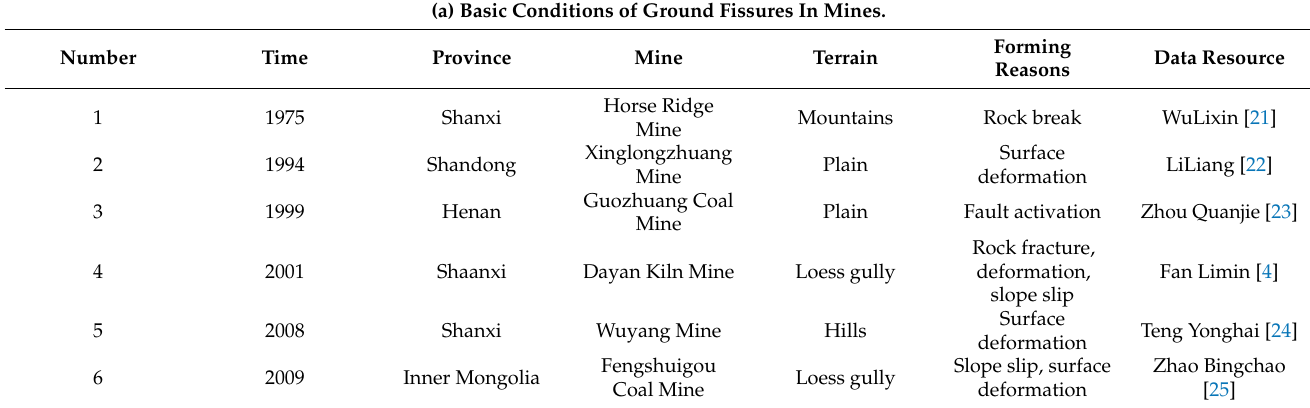
Table 1. Statistics of mining–induced ground fissures in